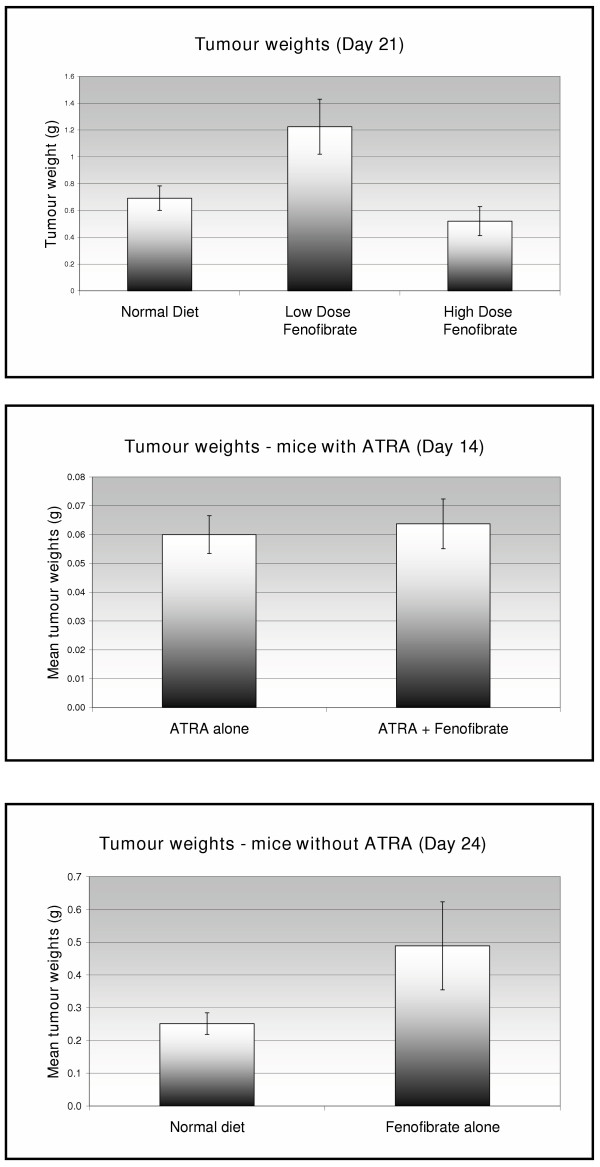
Tumour weights in nude mice following endometrial cancer cell xenografting and treatment with "high dose" (0.25%) or "low dose" (0.1%) fenofibrate. Top – n = 6 mice per group treated for 21 days. Middle – n = 8 mice per group treated for 14 days and Bottom – n = 8 mice per group treated for a further 10 days with fenofibrate alone. Tumour weights were lower in the high-dose fenofibrate-treated mice in the first experiment, but this was not repeated in the second experiment.